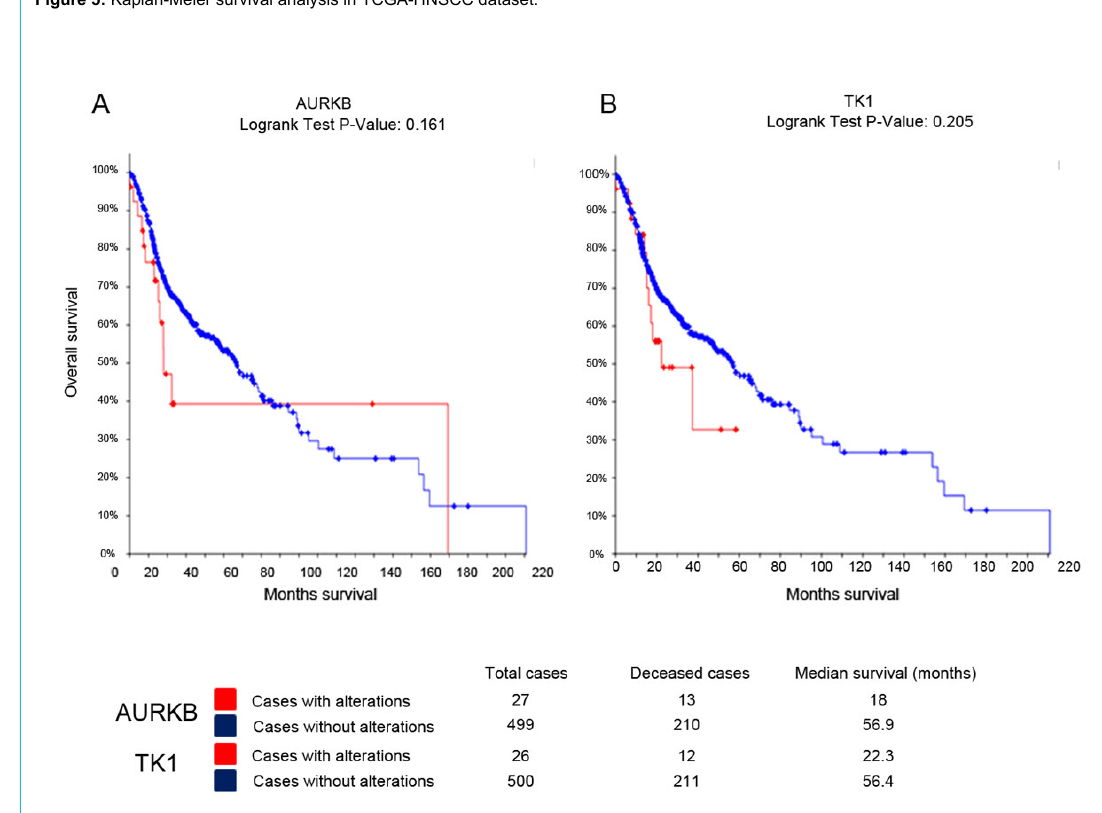
Figure 5: Kaplan-Meier survival analysis in TCGA-HNSCC